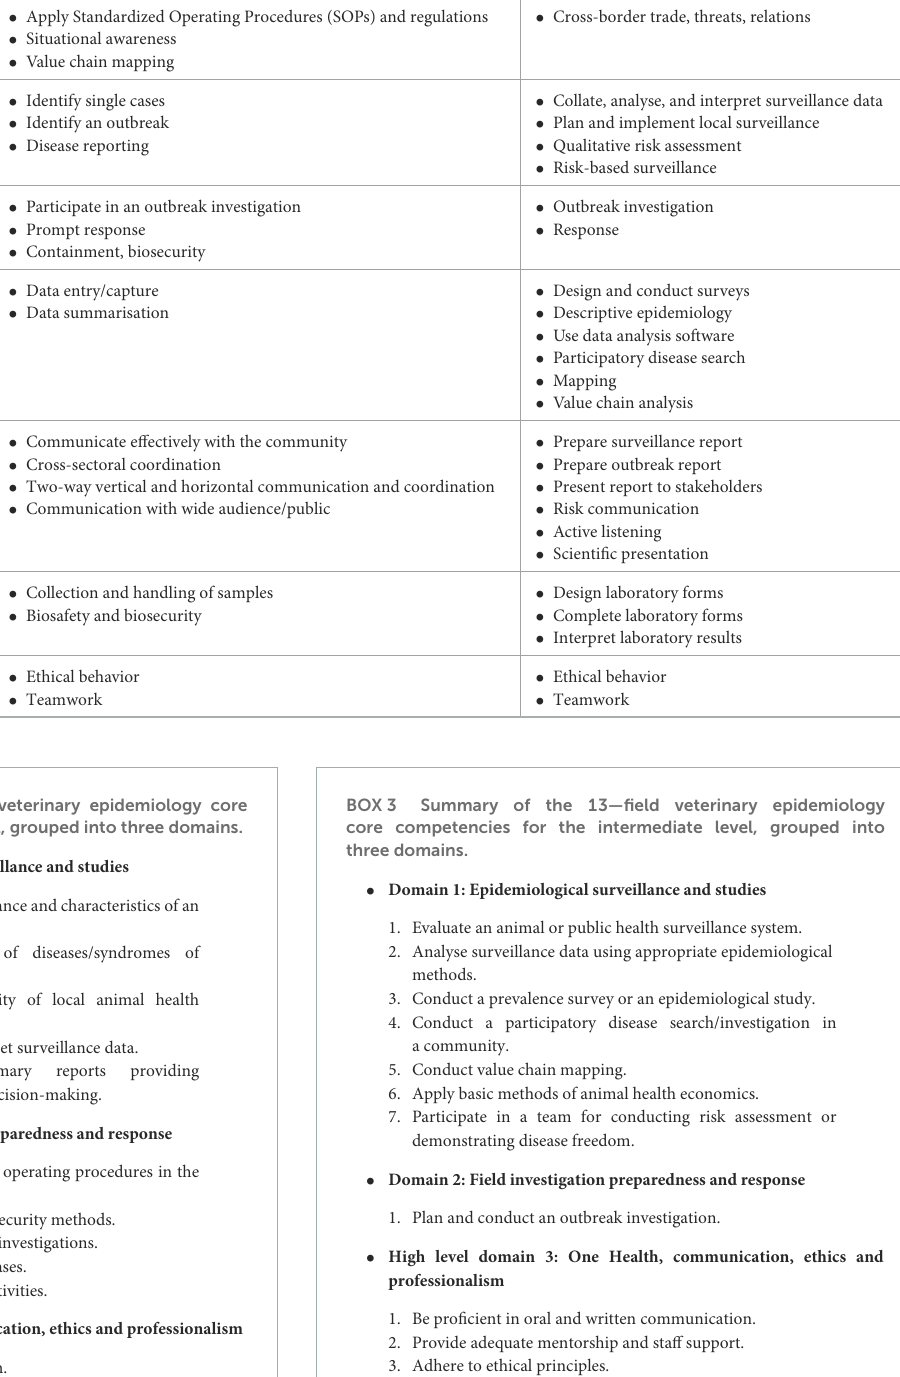
TABLE 1 Roles and responsibilities for field epidemiologists at the frontline and intermediate levels.